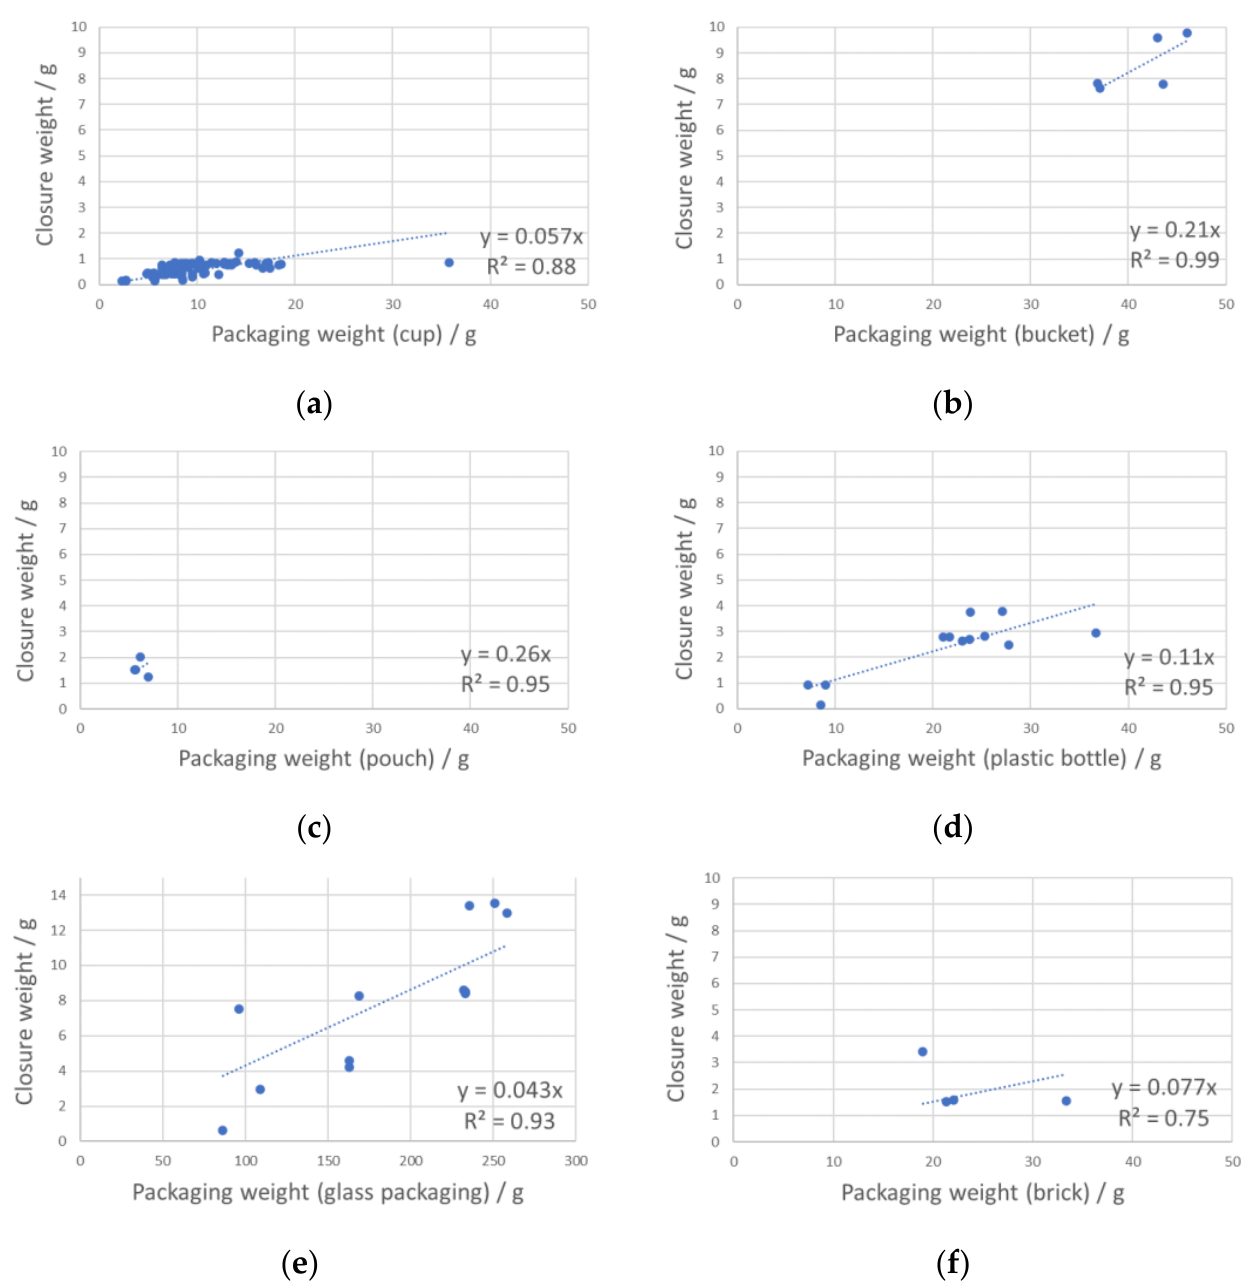
Figure 10. Closure weight versus packaging weight (all parts including wrapper and shrink label if applicable), ( a ): cup, ( b ): bucket, ( c ): pouch, ( d ): plastic bottle, ( e ): glass packaging, ( f ): brick; straight line equation with origin 0 applied .